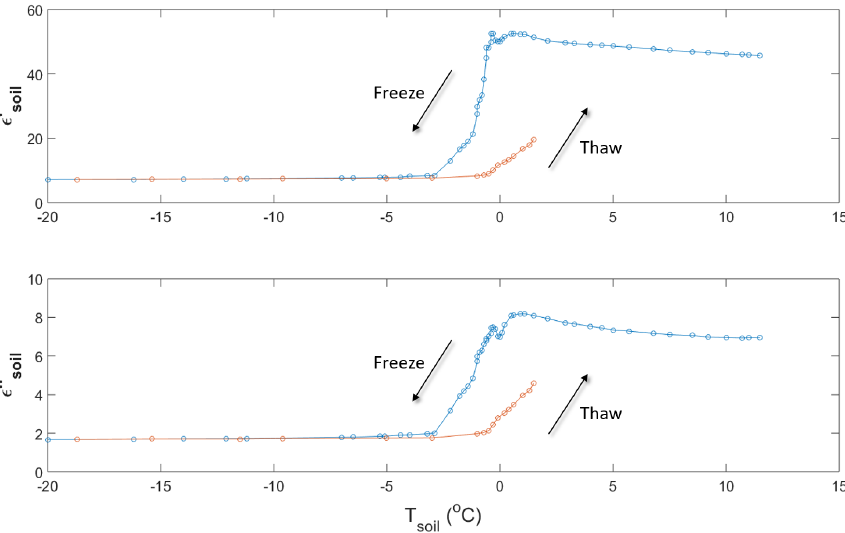
Figure 11. Real ( ε (cid:48) ) and imaginary ( ε (cid:48)(cid:48) ) permittivity of an organic soil sample from the Old Black Spruce site (collected 3 May 2017) during a slow freeze–thaw cycle in a temperature-controlled chamber environment. Experiment conducted 12 July